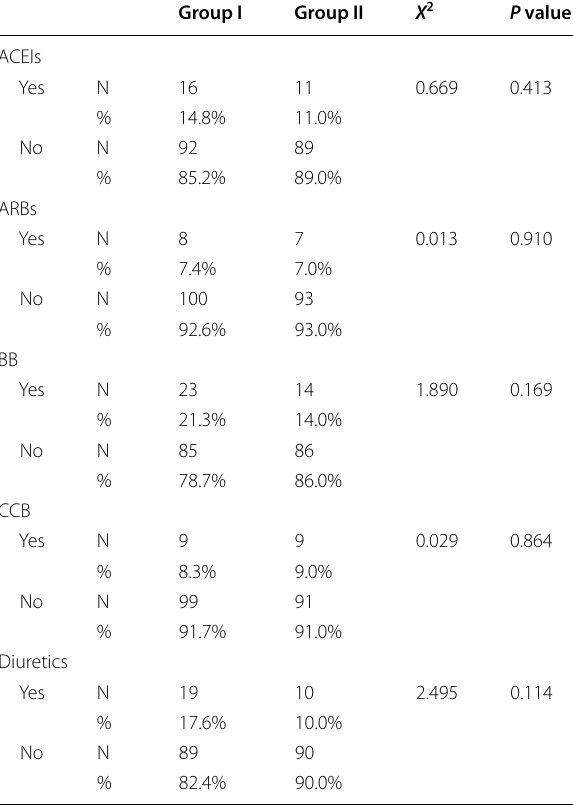
Table 3 Comparing echocardiographic parameters and BPV parameters in both